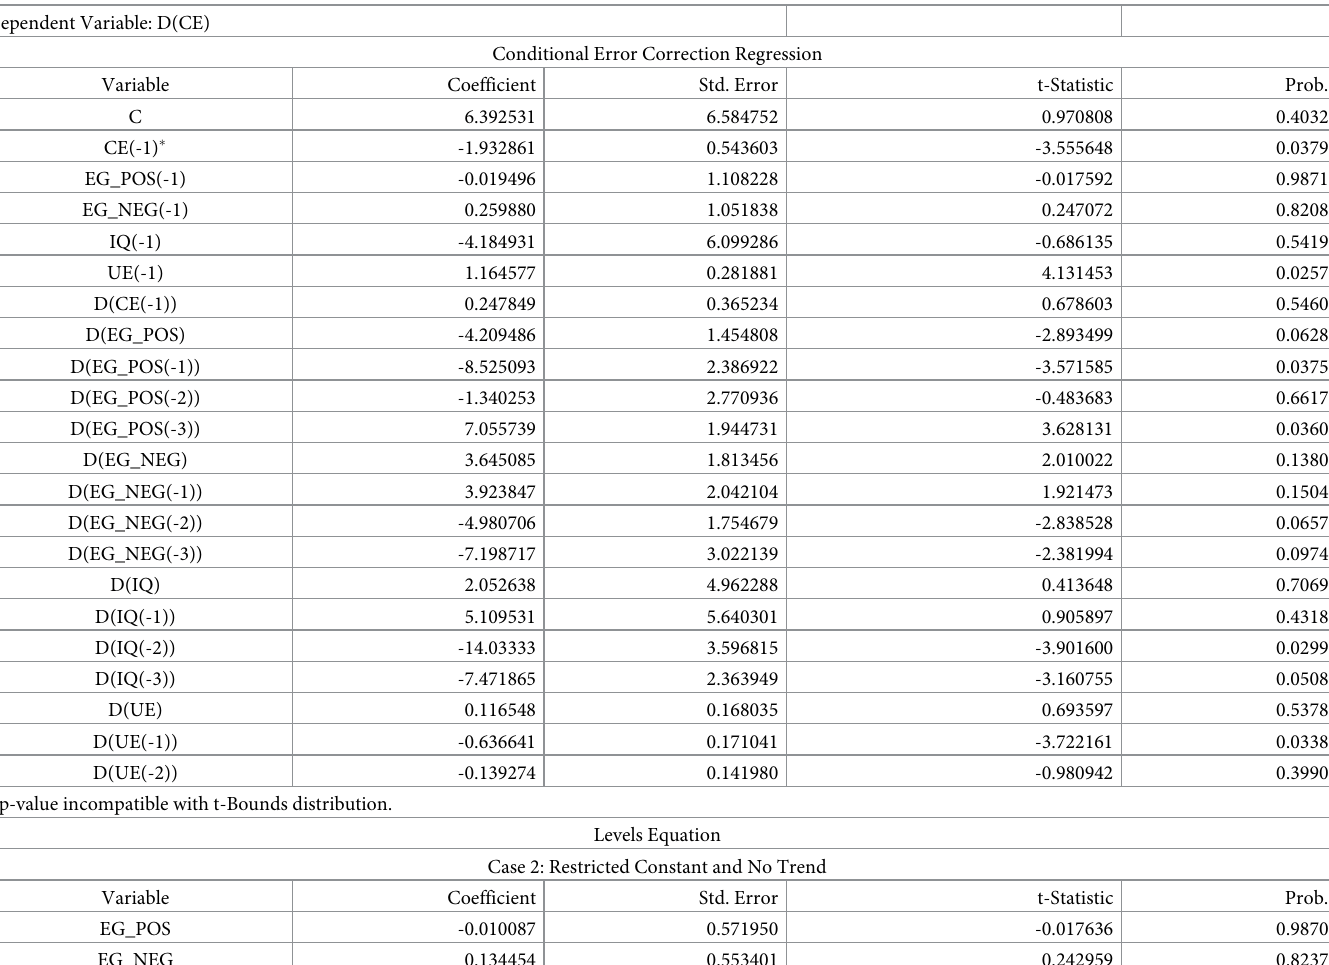
Table 4. ARDL long-run form and bounds